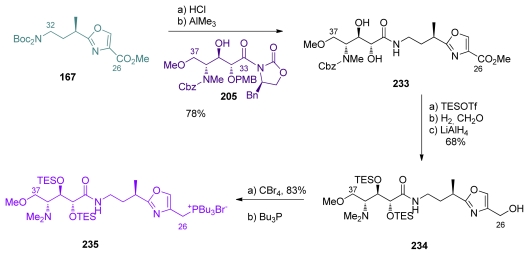
Preparation of the C26–C37 fragment 235.